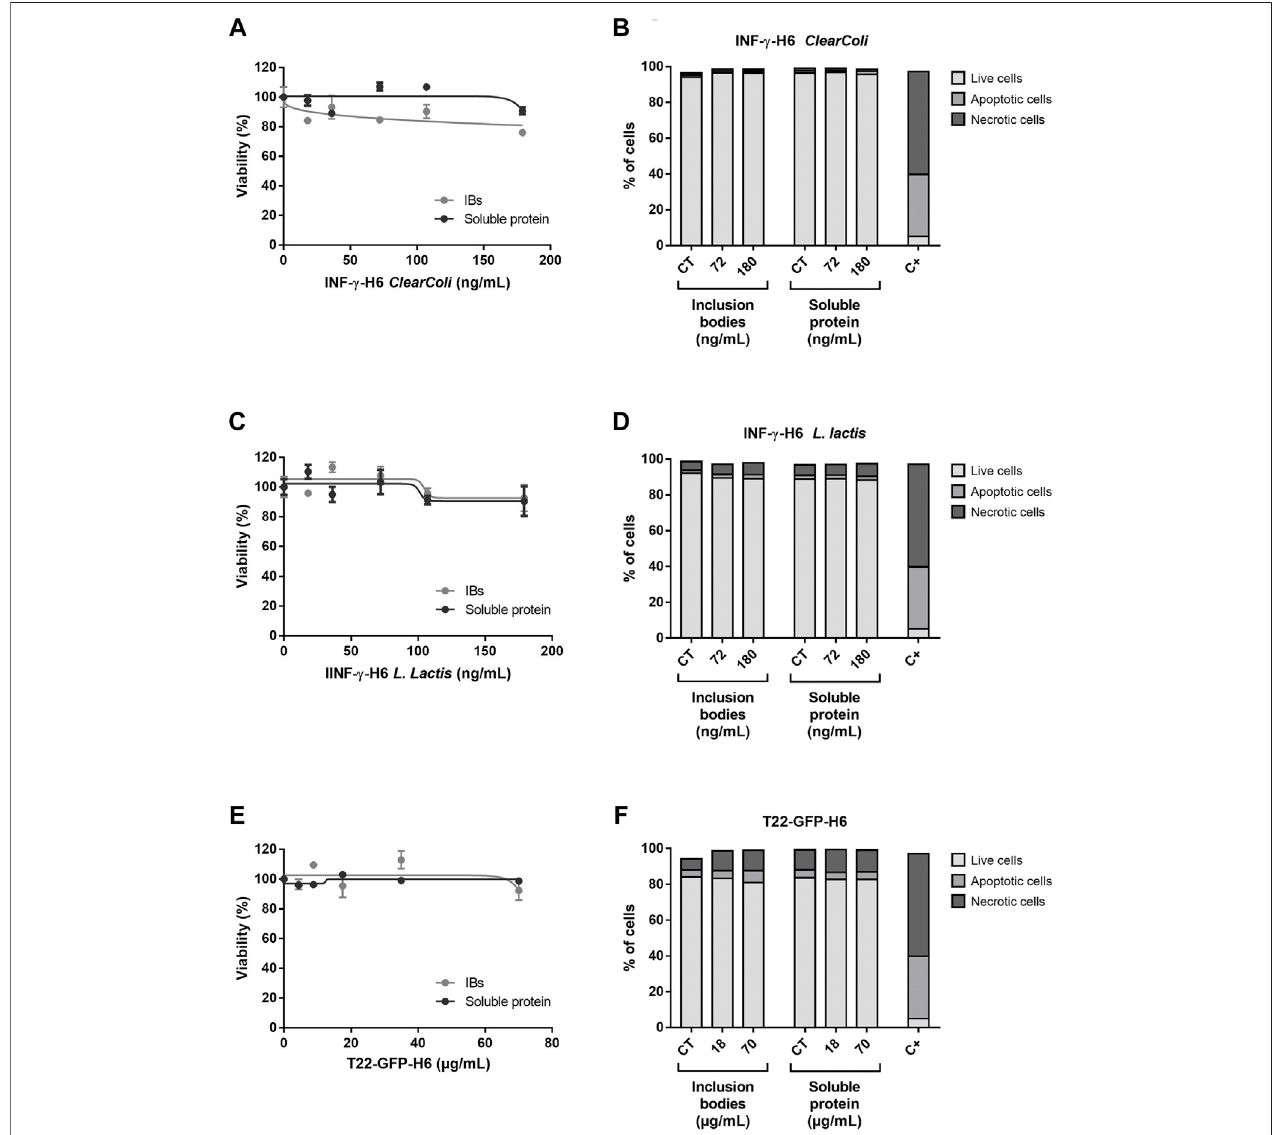
FIGURE1| Cytotoxicityofrecombinantproteins. (A,C,E) Cell viabilityofcaco-2 exposed for24 h toincreasingdoses ofINF- γ -H6 from ClearColi ® , INF- γ -H6 from L. lactis and T22-GFP-H6, respectively. Data are presented as number of exposed cells relative to the non-exposed controls ±SEM. (B,D,F) Percentage of live, apoptotic, and necroticcells inthe non-exposed controls, and cells exposed for 24 h toincreasing dosesof INF- γ -H6 from ClearColi ® , INF- γ -H6 from L. lactis and T22- GFP-H6, respectively. The positive control corresponds to the percentage of live, apoptotic, and necrotic cells after 30 min of exposure to H 2 O 2 . The data determined by Annexin V staining are presented as mean % ±